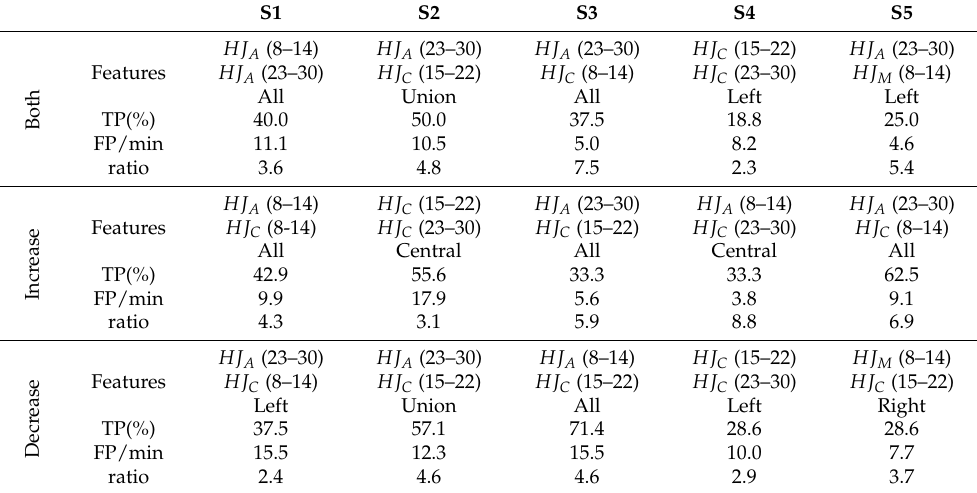
Table 4. Pseudo-online results per user showing TP, FP/min and ratio ( TP (calculated in the offline analysis) feature and electrodes combination for Both, Increase and Decrease